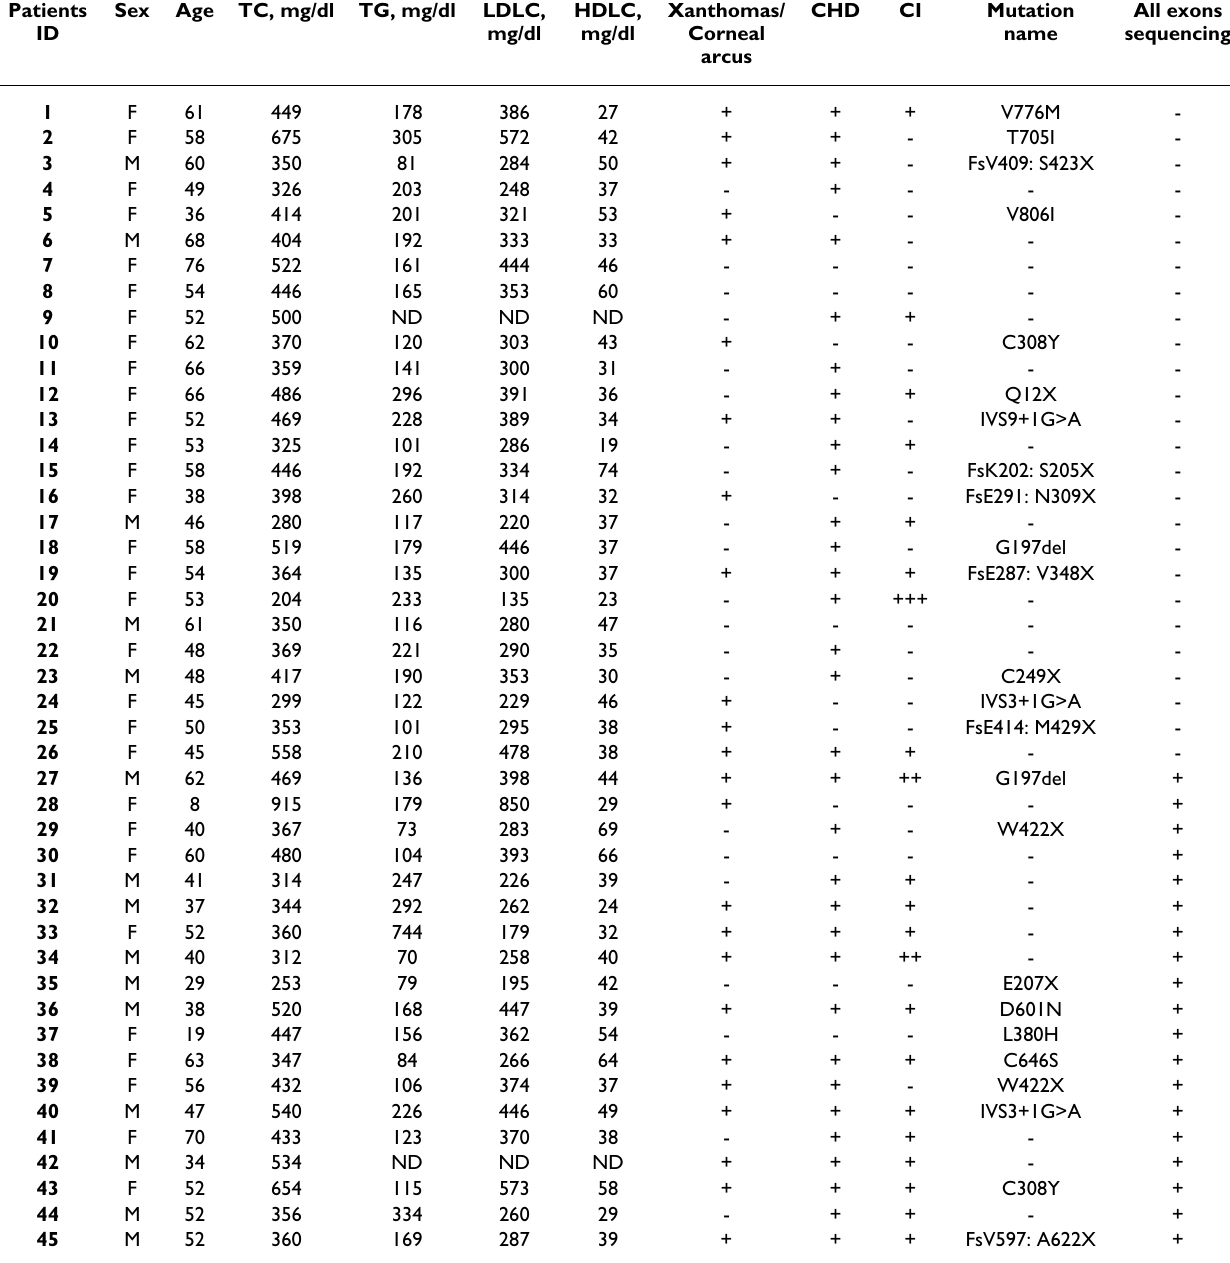
Table 2: Clinical features of St. Petersburg patients recruited for search of mutations in the LDL receptor gene Patients